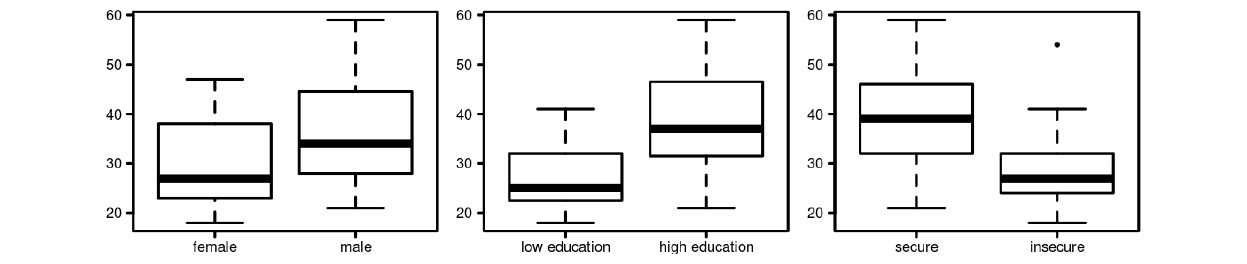
Fig. 1 . Comparison of sense of coherence scores among female and male respondents (left), respondents with high and low education (center), and respondents with secure and insecure livelihoods